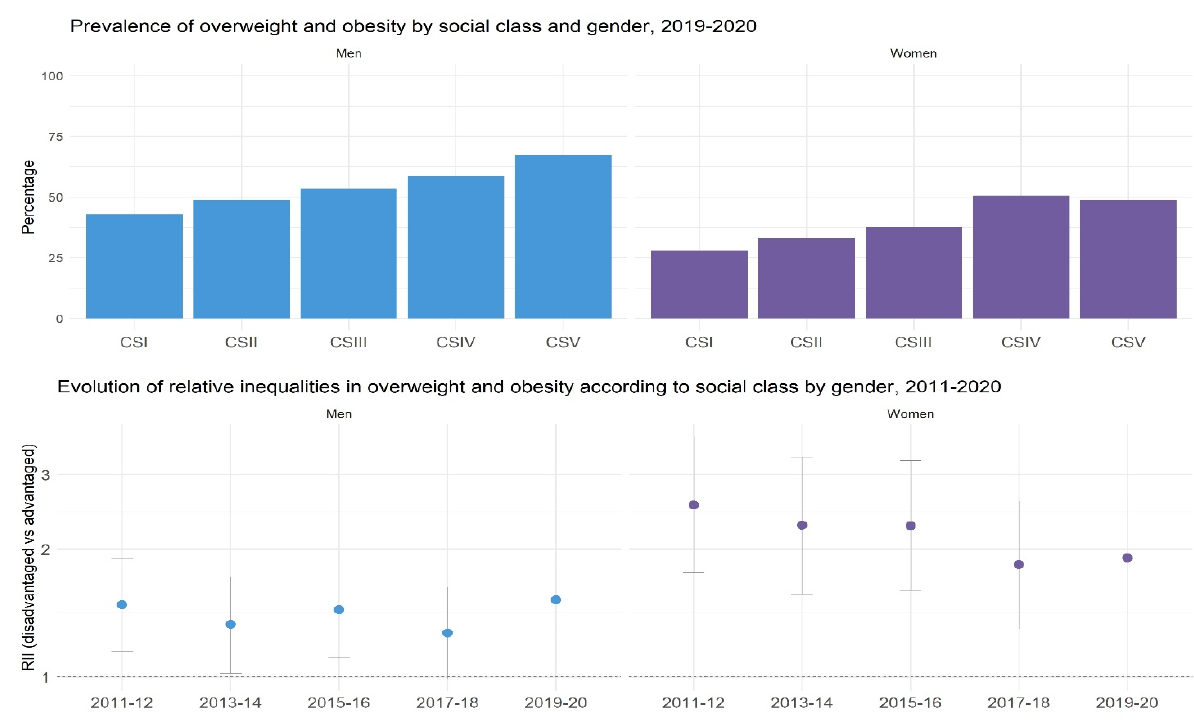
Figure 1. Example of fi gures included in the Barcelona Social Health Inequalities Surveillance Sys- tem. CS: social class, where I is the most advantaged, V the least advantaged, RII: Relative index of inequality comparing social classes. The fi gure includes population ≥ 15 years of age. inequality comparing social classes. The figure includes population ≥ 15 years of